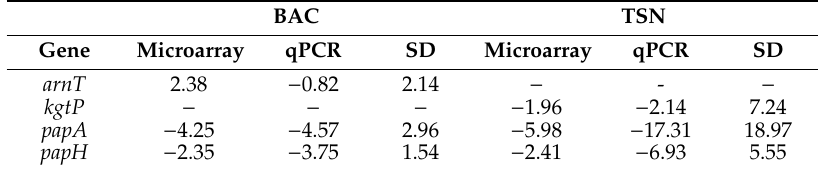
Table 3. Confirmation of fold change of selected genes by quantitative real-time PCR. Fold change values for qPCR are mean values of 2 − ∆∆ CT obtained from three biological replicates, reported with the